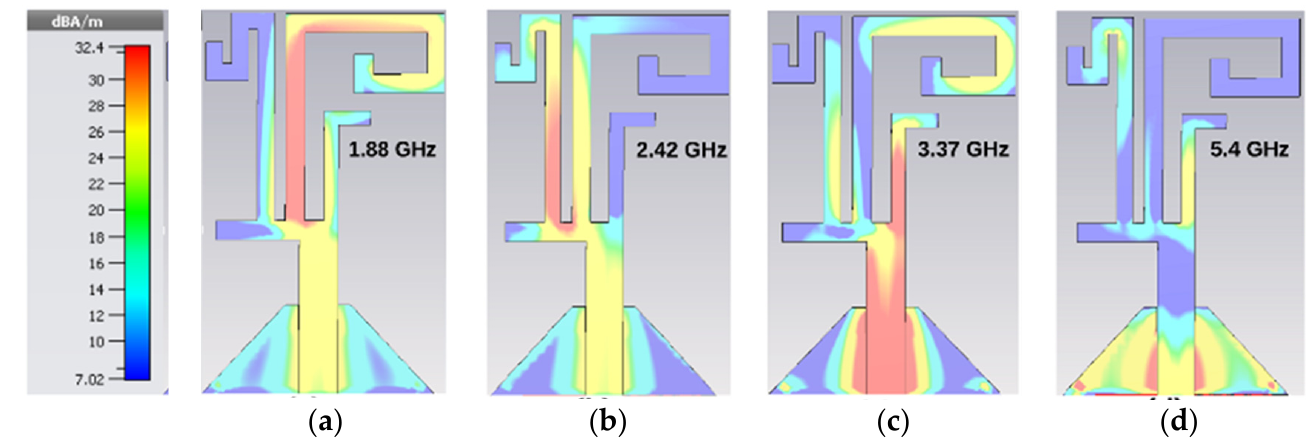
Figure 4. Surface current distribution at ( a ) 1.88 GHz, ( b ) 2.42 GHz, ( c ) 3.37 GHz, ( d ) 5.4 GHz.